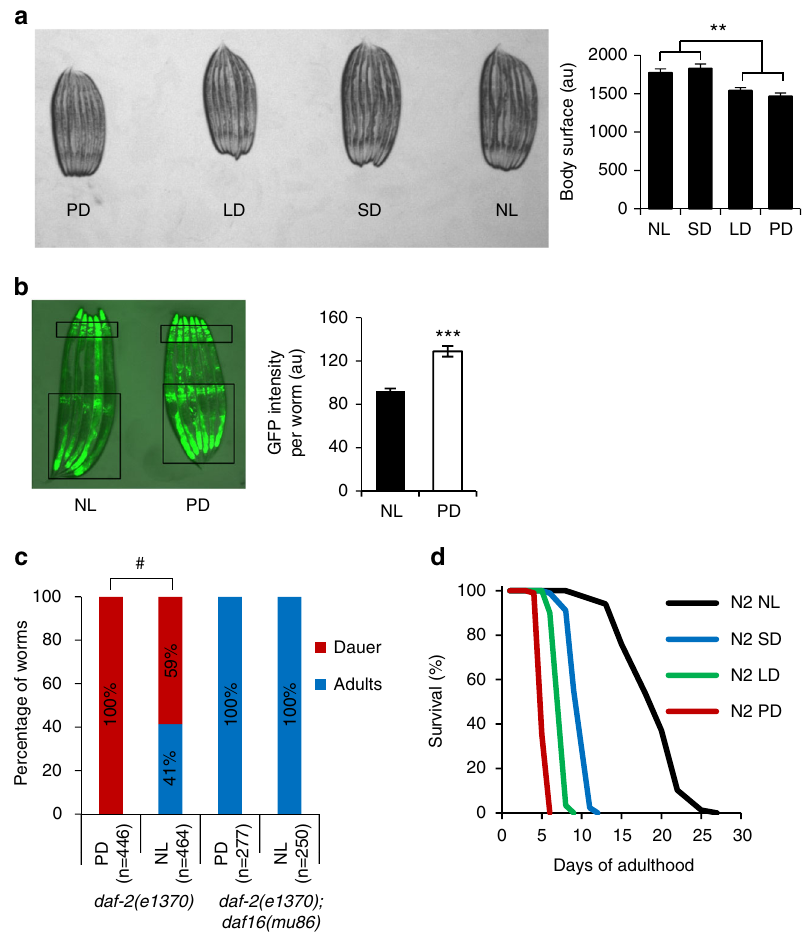
Fig. 2 Light exposure affects C. elegans development. a Left, appearance of D1 adult N2 worms having been exposed to the four photoperiods from hatch; right, quanti fi cation of body surface from the left panel. b sod-3p ::GFP worms exposed to permanent light or no light from hatch and observed at D1 adult under a GFP fl uorescent fi lter (left) and quanti fi cation of the fl uorescence (right); black rectangles indicate known areas of sod-3p ::GFP expression where fl uorescence was quanti fi ed. c daf-2(e1370) worms raised from hatch at 22 °C under permanent light or no light and quanti fi ed at +72 h for dauer or adult stage. daf-2(e1370);daf-16(mu86) strain was used as a negative control. d Lifespan of N2 worms raised until D1 adult under NL and from D1 onward under the four different photoperiods. In panels a and b, bars represent mean ± SEM, ** P < 0.01; *** P < 0.001 using Student ’ s t test. #, P < 0.001 using Fisher ’